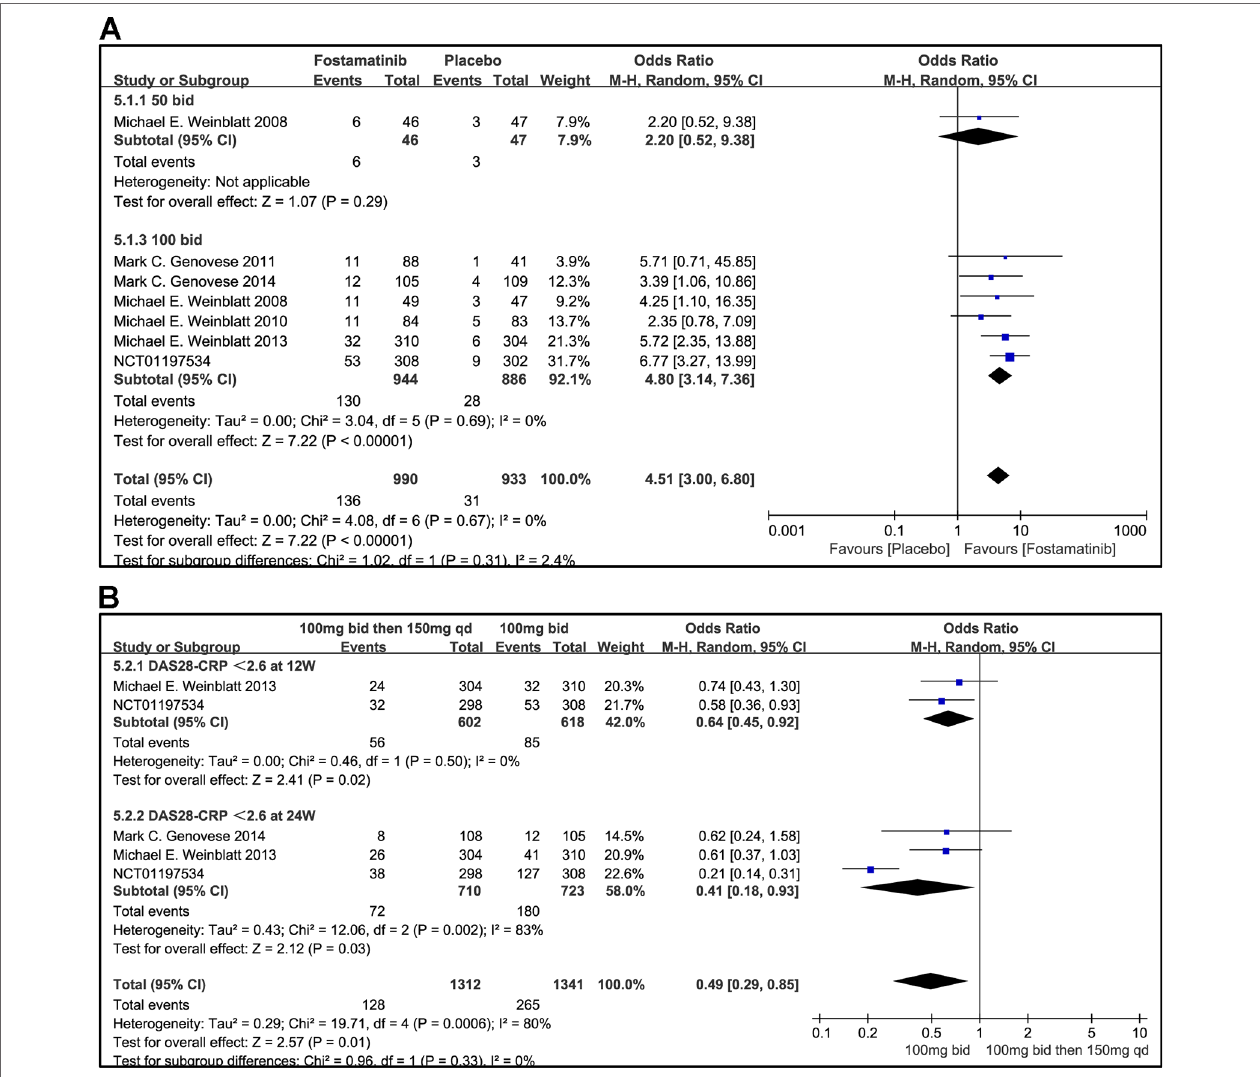
FIGURE 7 | Forest plots for the effect of multiple doses on DAS28-CRP < 2.6 at different time points. (A) Subgroups administered multiple doses (50 and 100 mg bid) of fostamatinib compared to placebo at 24 weeks from baseline; (B) 100 mg bid for 4 weeks followed by 150 mg bid vs. 100 mg bid at 12 and 24